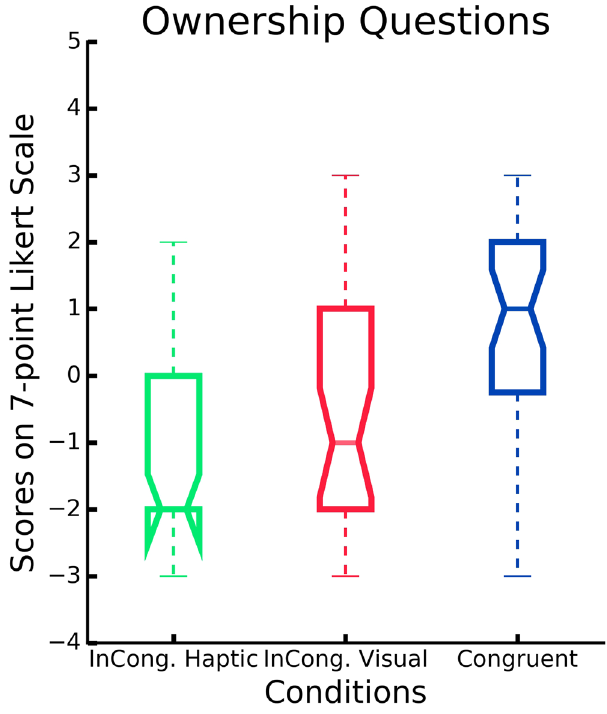
Figure 3. Self-reported experience of ownership. Y-axis: Responses on the 7-point Likert scale ranging from −